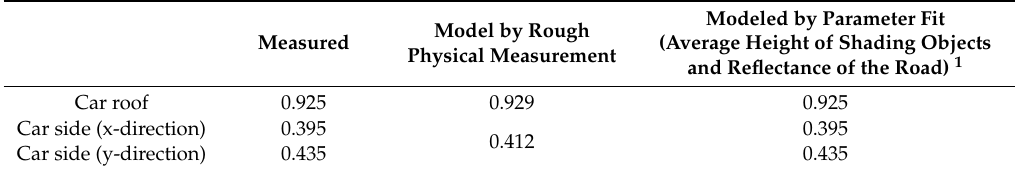
Table 2. Comparison of model and measurement (relative to GHI) by one-year monitoring of a passenger’s car. Modeled by Parameter Fit Model by Rough Measured (Average Height of Shading Physical Measurement